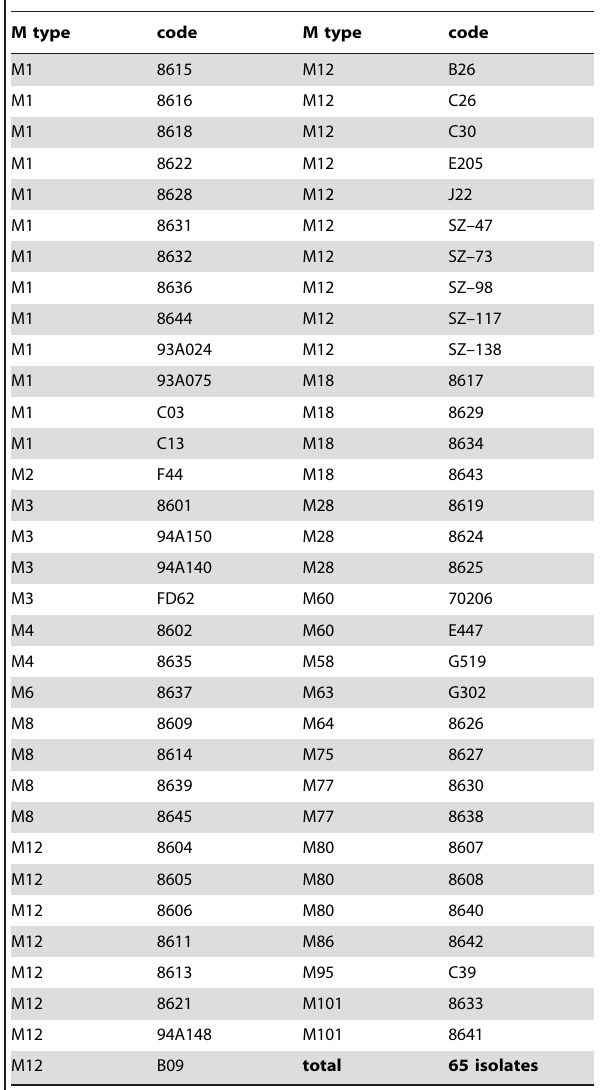
Table 2. 65 GAS isolates used in the study.